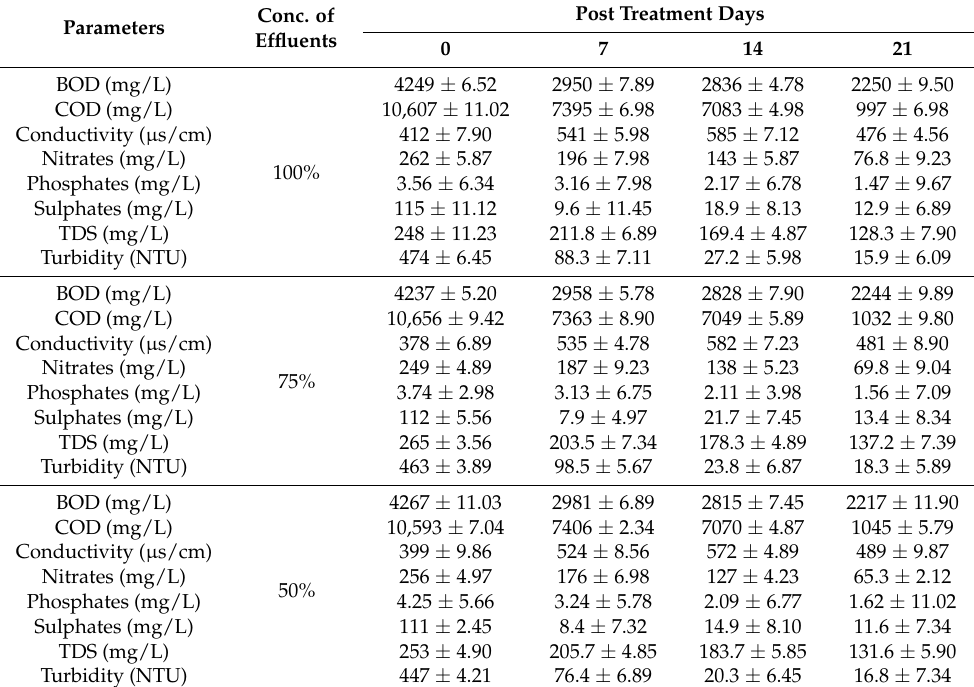
Table 2. The physicochemical features of different concentrations of tannery effluents treated with Torulaspora delbrueckii